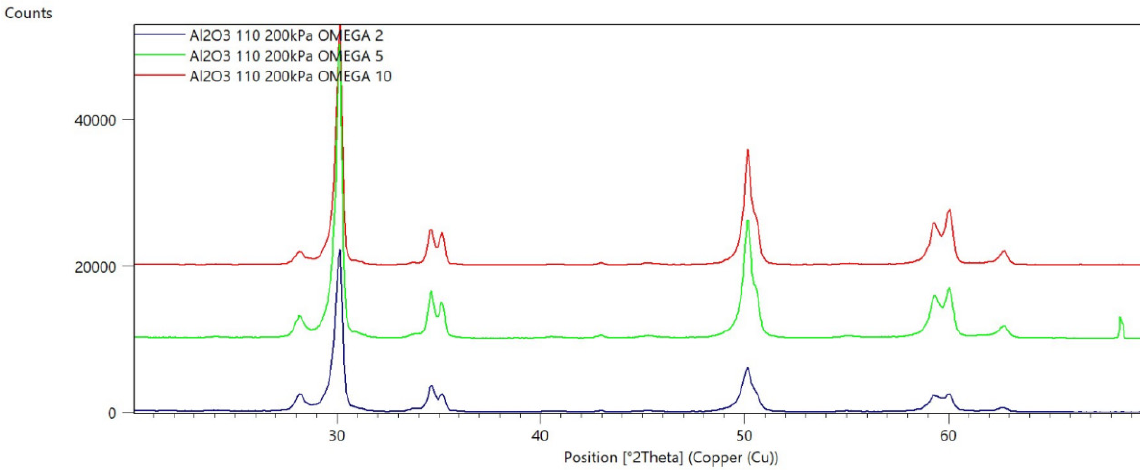
Figure 4. Diffraction patterns of sample C (abrasive—Al 2 O 3 110 µ m, pressure 200 kPa).